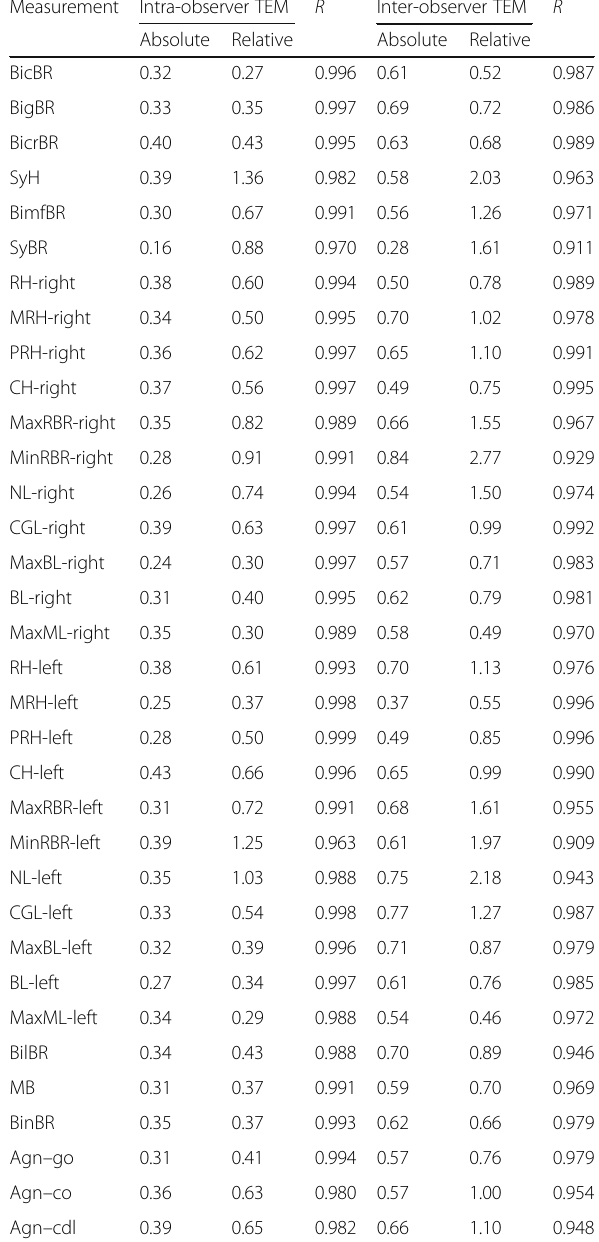
Table 2 Intra- and inter-observer error results Measurement Intra-observer